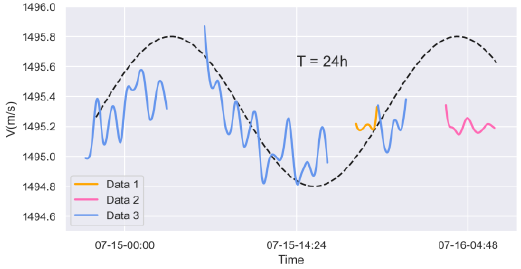
Figure 10 . Time variation of the sound speed.